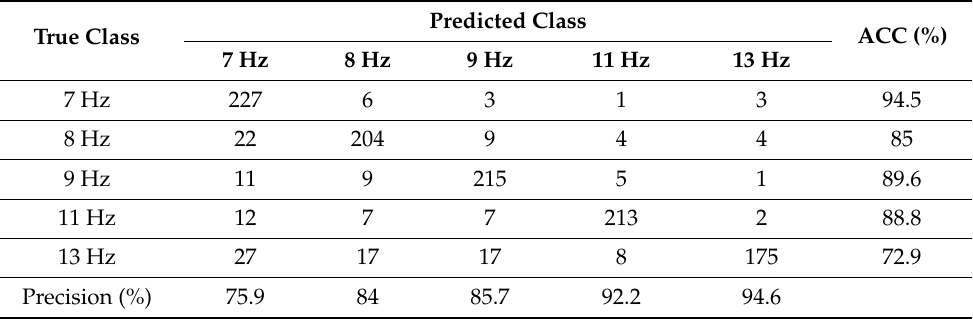
Table 4. The confusion matrix for the SSVEP recognition results using MSI classifier for the direction test in the first experiment (Scenario 1).